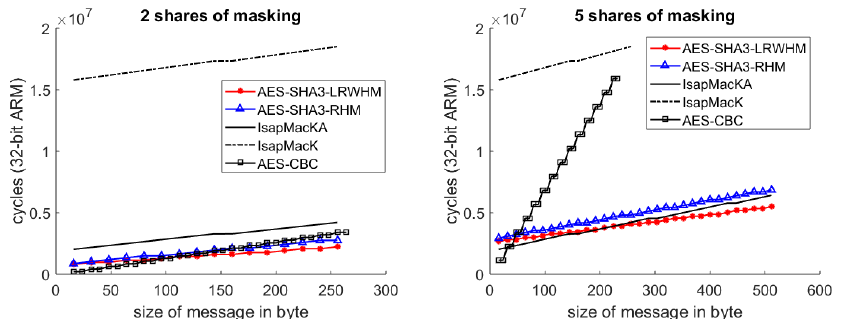
Figure 6: Performance (I): the consumed clock cycles of AES-SHA3- LRWHM , AES-SHA3- RHM , IsapMac s and AES-CBC with varying the size of messages (lower is better).